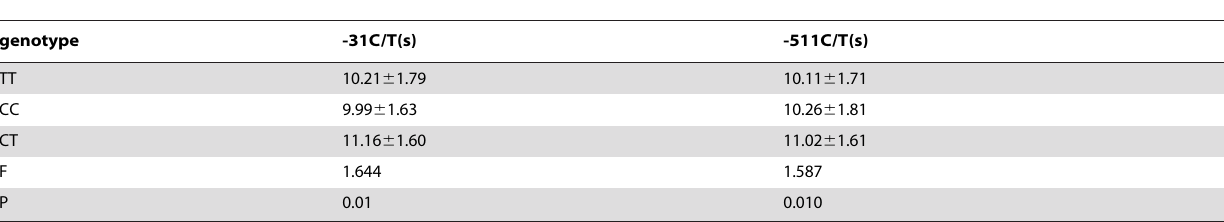
Table 5. The PT plasma level of PE among different